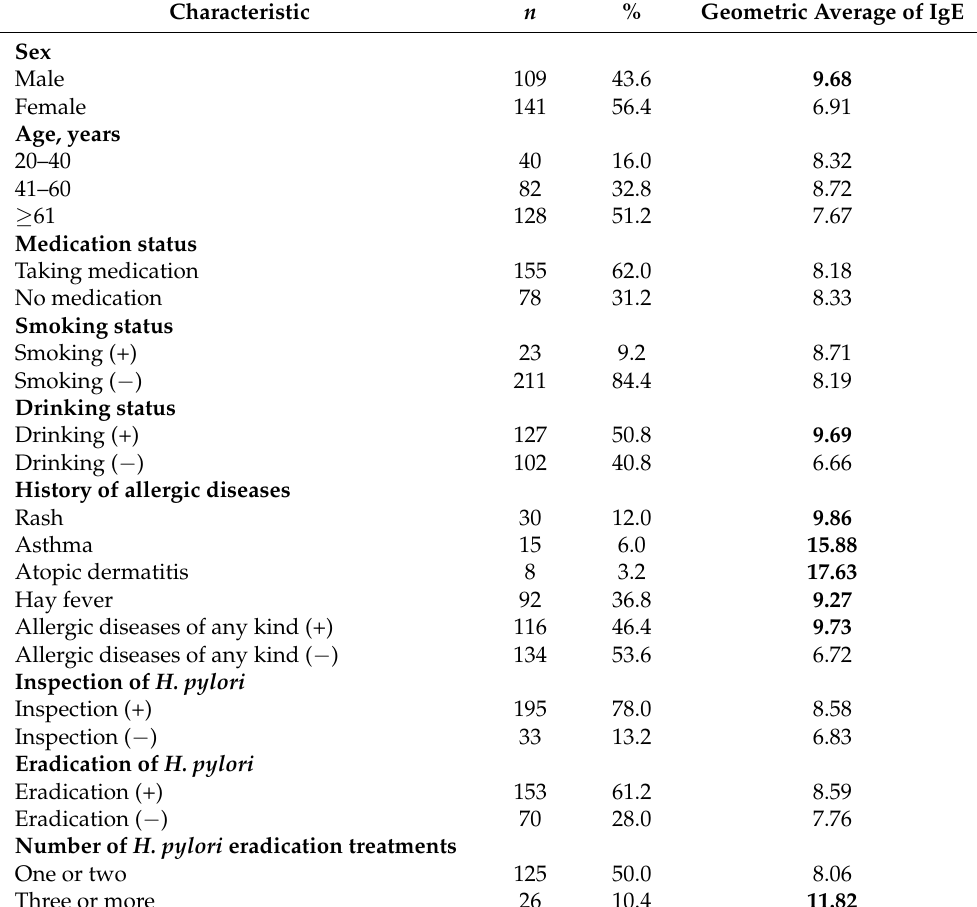
Table 1. Patients’ demographic